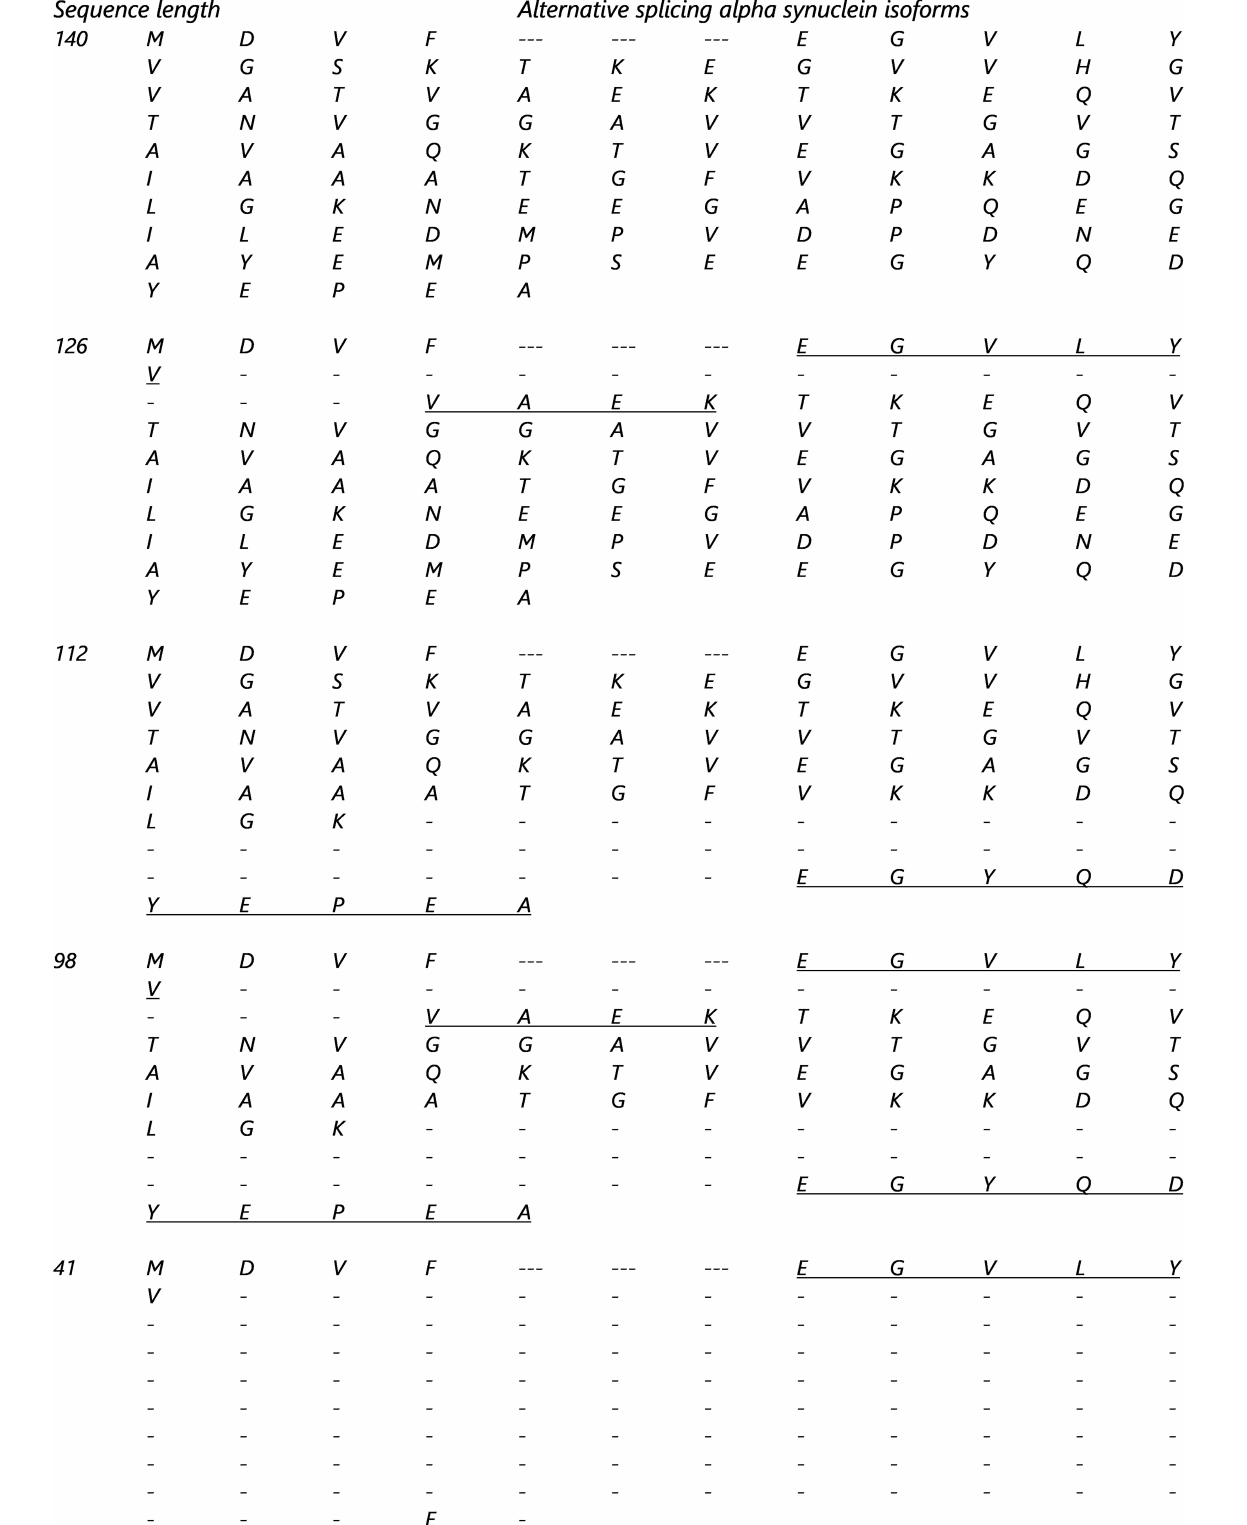
FIGURE 1 | Alternative splicing isoforms sequences. The underline amino acids are proteotypic and tryptic peptides created by the alternative splicing of the SNCA gene: Common part of all the isoforms and are composed of the following residue [MKGLSKAKEGVVAAAEKTKQGVAEAAGKTK].